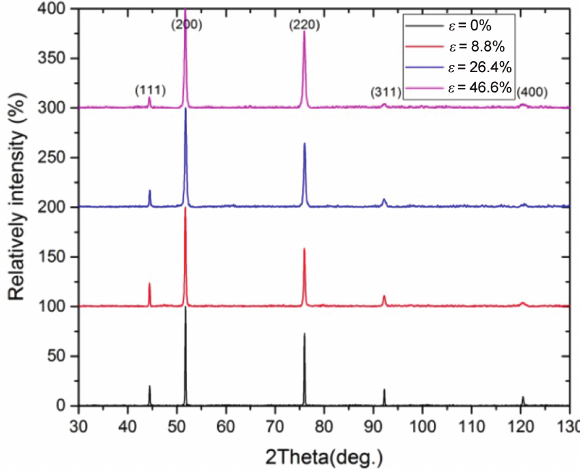
Figure 6: XRD patterns (diffraction intensity normalization processing) of drawn specimens with different engineering